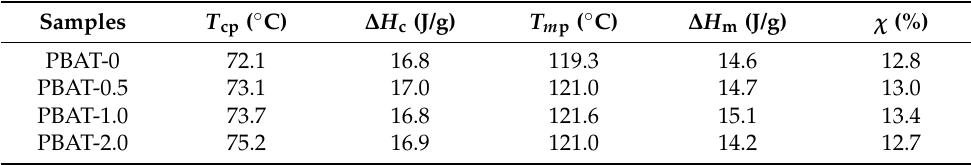
Figure 3. Differential scanning calorimetry (DSC) thermograms of PBAT/Ti 3 C 2 T X nanocomposites. ( a ) first cooling, ( b ) second heating. Table 2. DSC thermograms of PBAT/Ti 3 C 2 T X nanocomposites.